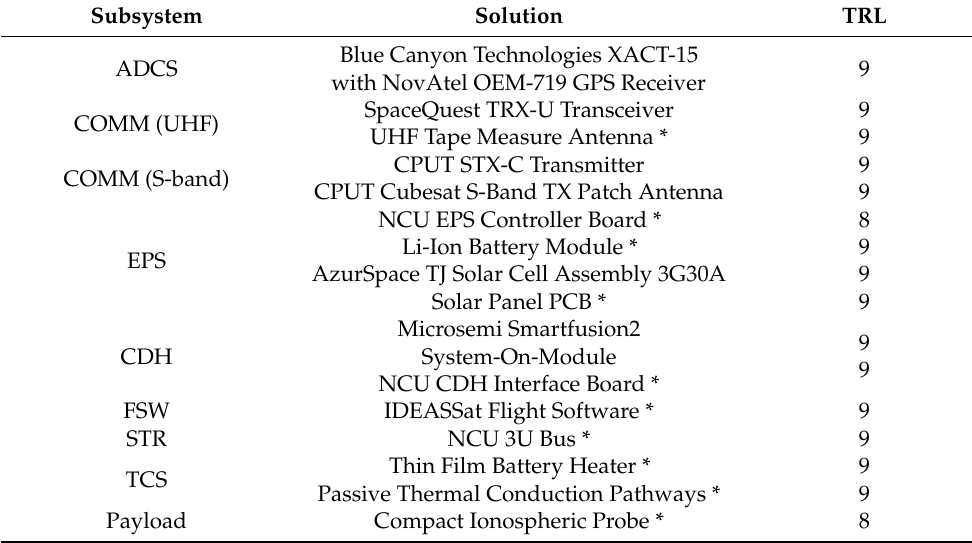
Table 1. Subsystem solutions used to implement IDEASSat FM and TRL at time of decommissioning. Subsystems developed and fabricated in-house are designated by an asterisk